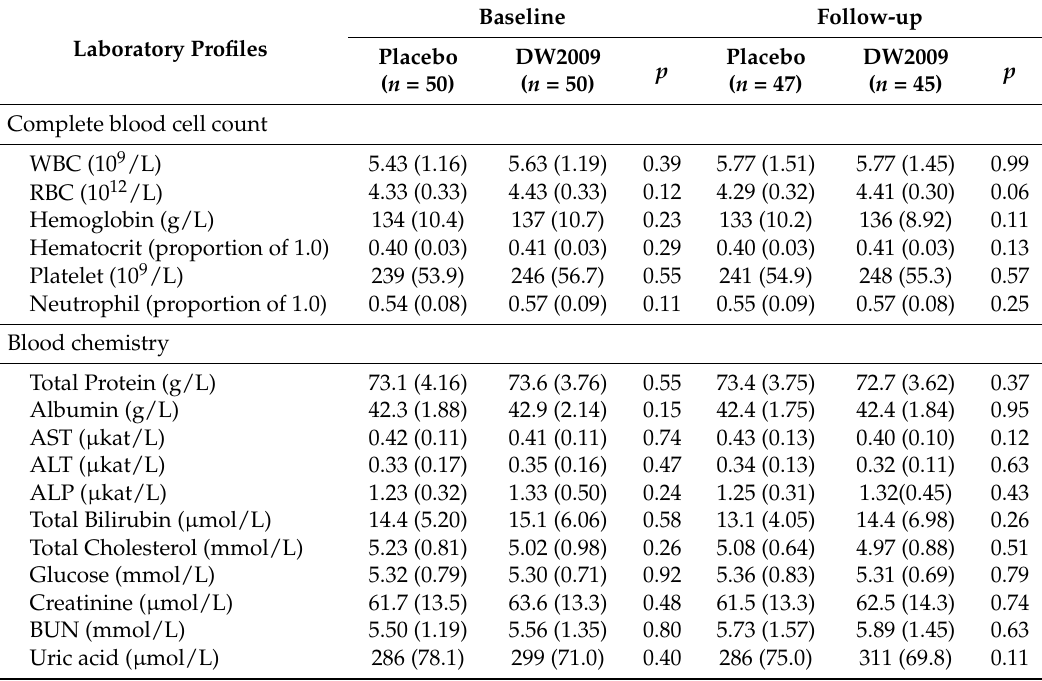
Table 5. Laboratory profiles of study participants assigned to the DW2009 and placebo